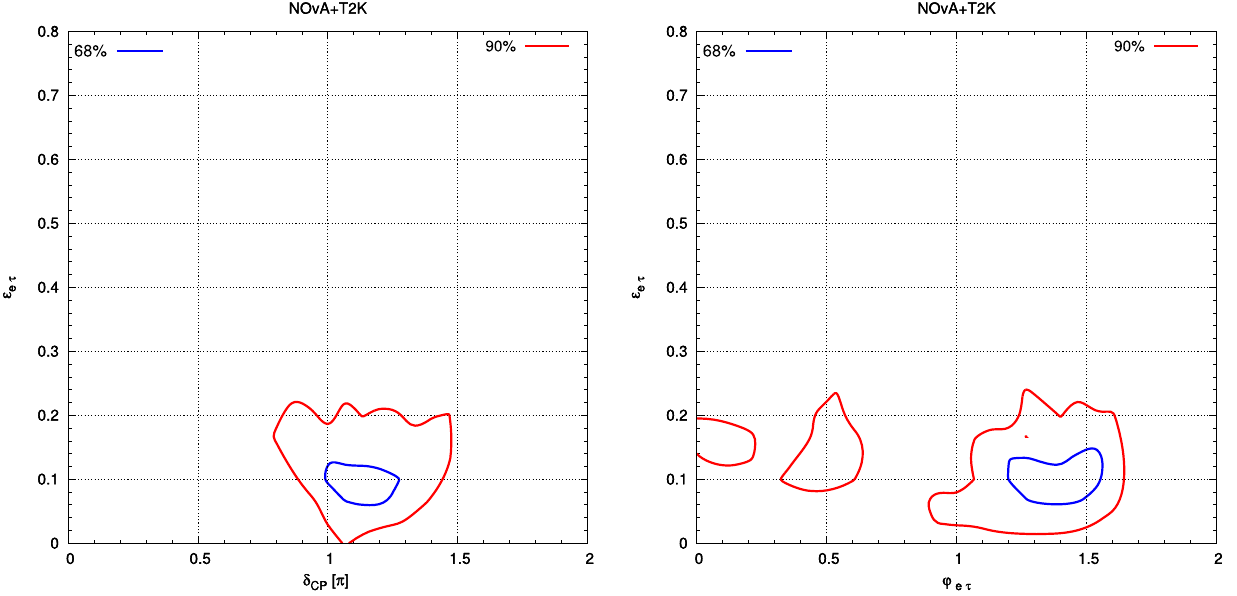
Fig. 2 Allowed regions for coupling (cid:5) e τ and CP phase (left); (cid:5) e τ and phase φ e τ (right) determined by the combination of T2K and NO ν A for NO. The contours are drawn at the 68% and 90% C.L. for 2 d.o.f Table 1 From allowed region Mass plots, the best fit points are listed here. The best fit points are picked up corresponding to the minimum χ 2 value. These values are also included in the below table